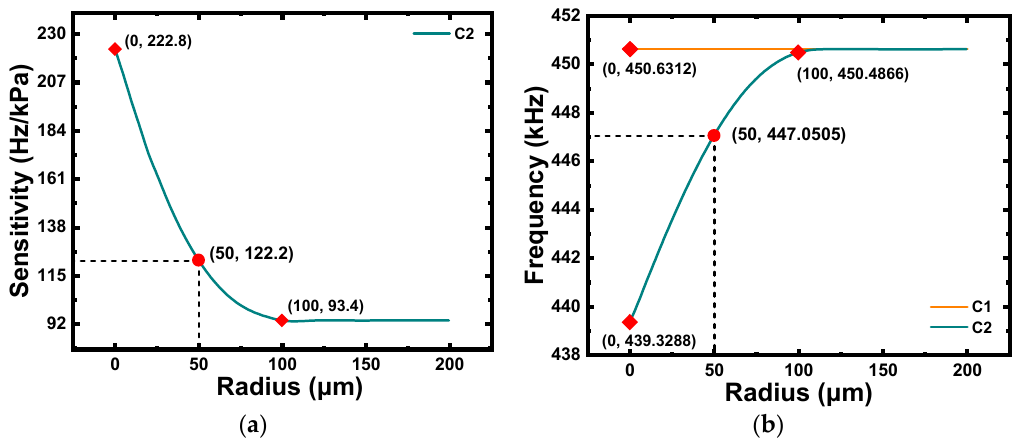
Figure 7. ( a ) Pressure sensitivity of C2 under pressures of 0–10 kPa (0 µ m ≤ r c ≤ 200 µ m ). ( b ) Comparison of resonant frequencies of C1 and C2 under pressure of 0 Pa (0 µ m ≤ r c ≤ 200 µ m ).